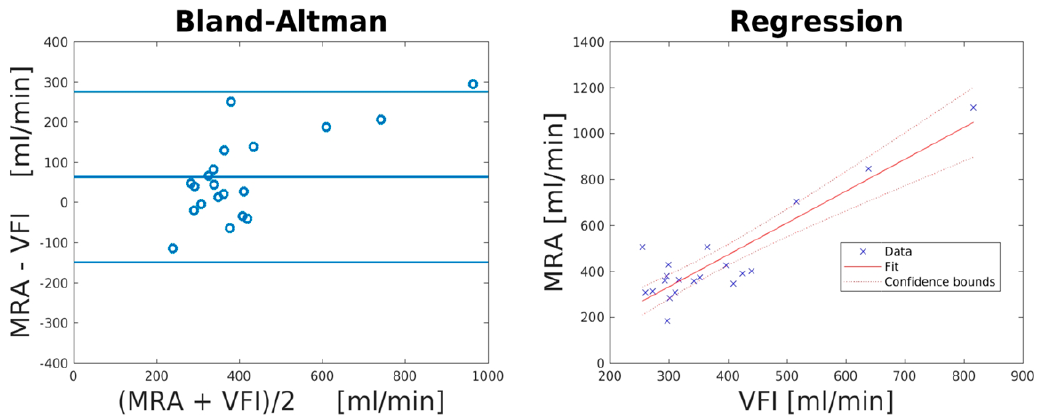
Figure 3. Volume flow estimations with VFI and MRA of the CCA evaluated with Bland–Altman and linear regression plots. The lines in the Bland–Altman plot ( left ) correspond to the mean bias and LOA, while the lines in the linear regression plot ( right ) correspond to line of best fit and confidence bounds. Notice a larger positive bias for higher volume flows, indicating a systematic bias. Table 1. Mean and range of the replicated MRA and VFI estimations. (1) represents the first acqui- sition and (2) the second.